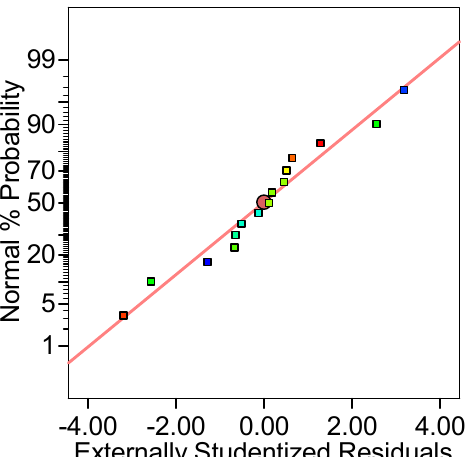
Figure 3. The Normal probability plot of residuals obtained for RB desorption efficiency.